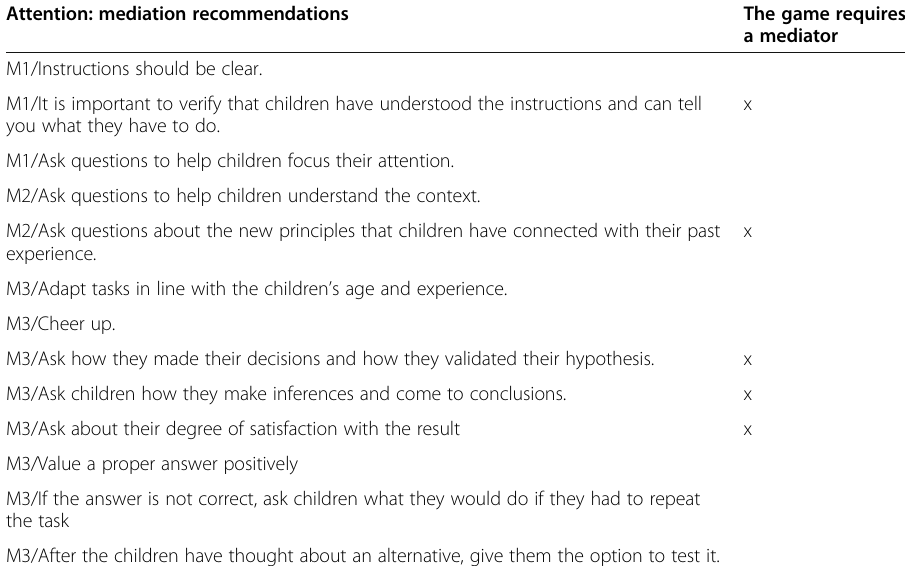
Table 4 Attention: mediation recommendations for interactive serious games Attention: mediation